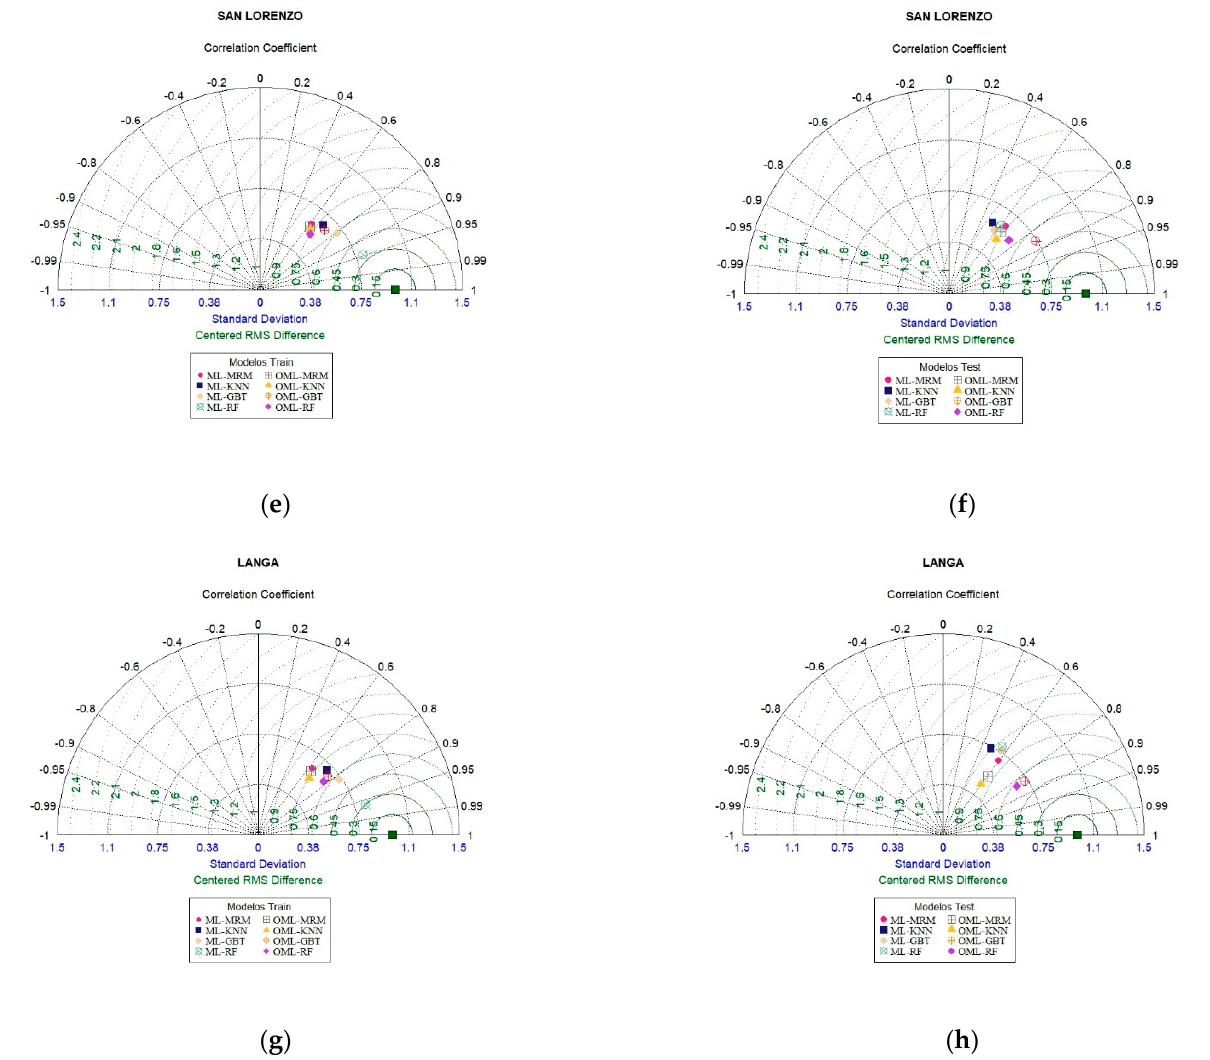
Figure 11. Taylor diagrams that show a statistical comparison (normalized standard deviation and correlation coefficient) of observed precipitation and modeled precipitation based on precipitation datasets (training and test) for four stations: ( a ) Ayaviri (training), ( b ) Ayaviri (test), ( c ) Huarochiri (training), ( d ) Huarochiri (test), ( e ) San Lazaro de Escomarca (training), ( f ) San Lazaro de Escomarca (test), ( g ) Langa (training), and ( h ) Langa (test).